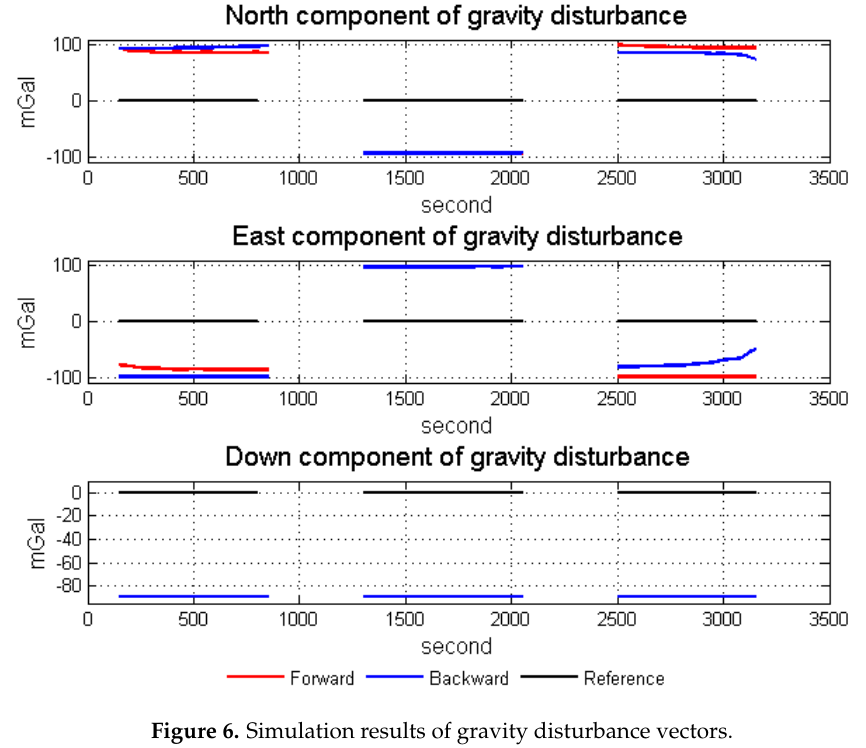
Figure 6. Simulation results of gravity disturbance vectors.